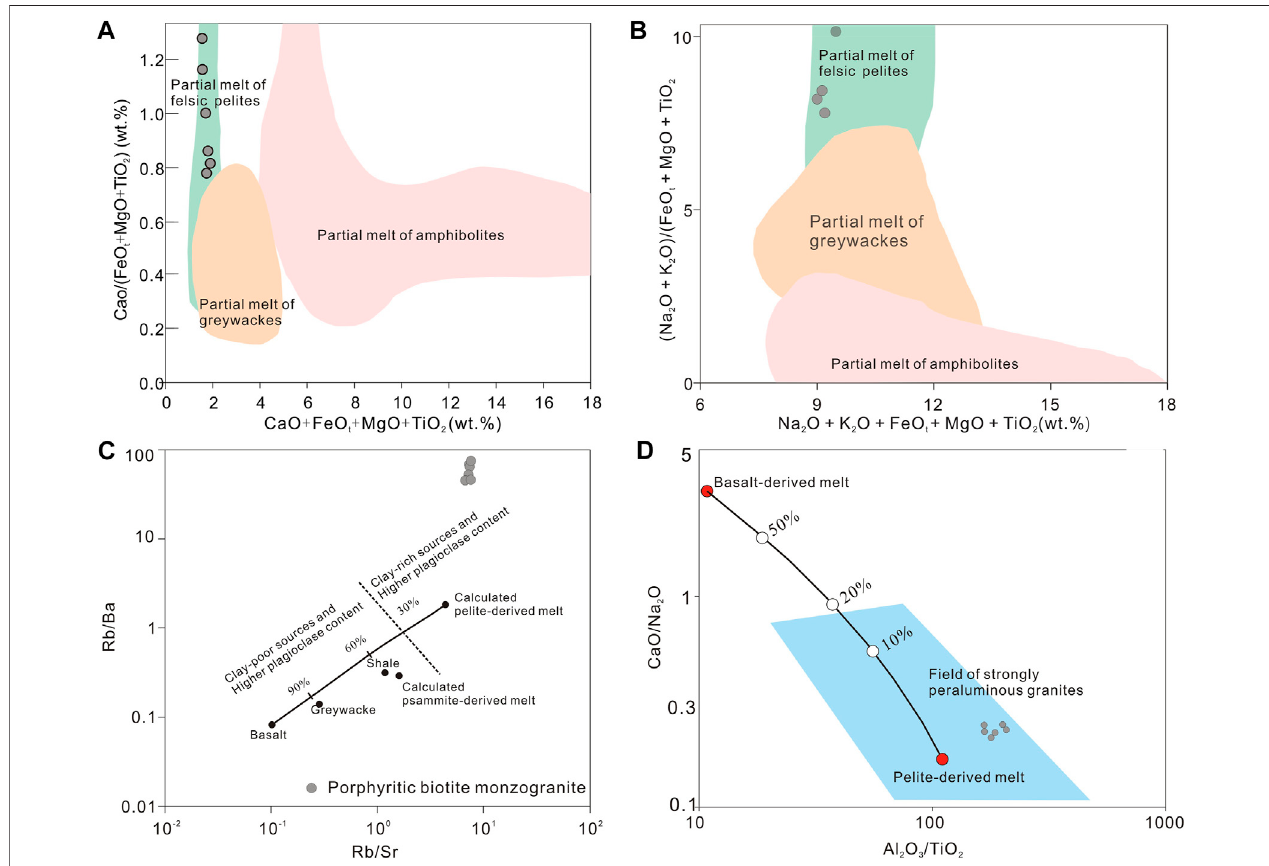
FIGURE10|(A) (CaO)/(FeO t +MgO+TiO 2 )vs(CaO+FeO t +MgO+TiO 2 ); (B) (Na 2 O+K 2 O)/(FeO t +MgO+TiO 2 )vs(Na 2 O+K 2 O+FeO t +MgO+TiO 2 ).Fieldsin (A) and (B) arefromPati ň o-DouceandHarris.(1999); (C) Rb/BavsRb/Sr; (D) CaO/Na 2 OvsAl 2 O 3 /TiO 2 .Themixingcurvebetweenthebasalt-andpelite-derivedmeltsin Figures 11C,D is from Pati ň o-Douce and Harris (1998) and Sylvester (1998).